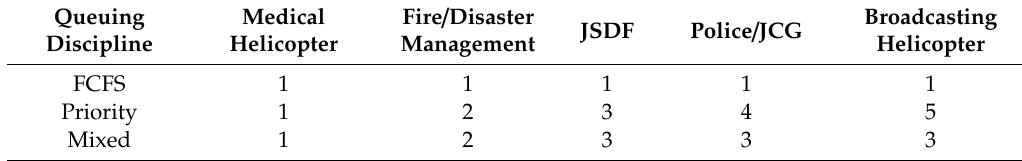
Table 3. Applying queuing priority to each aircraft operator (1 to 5: highest to